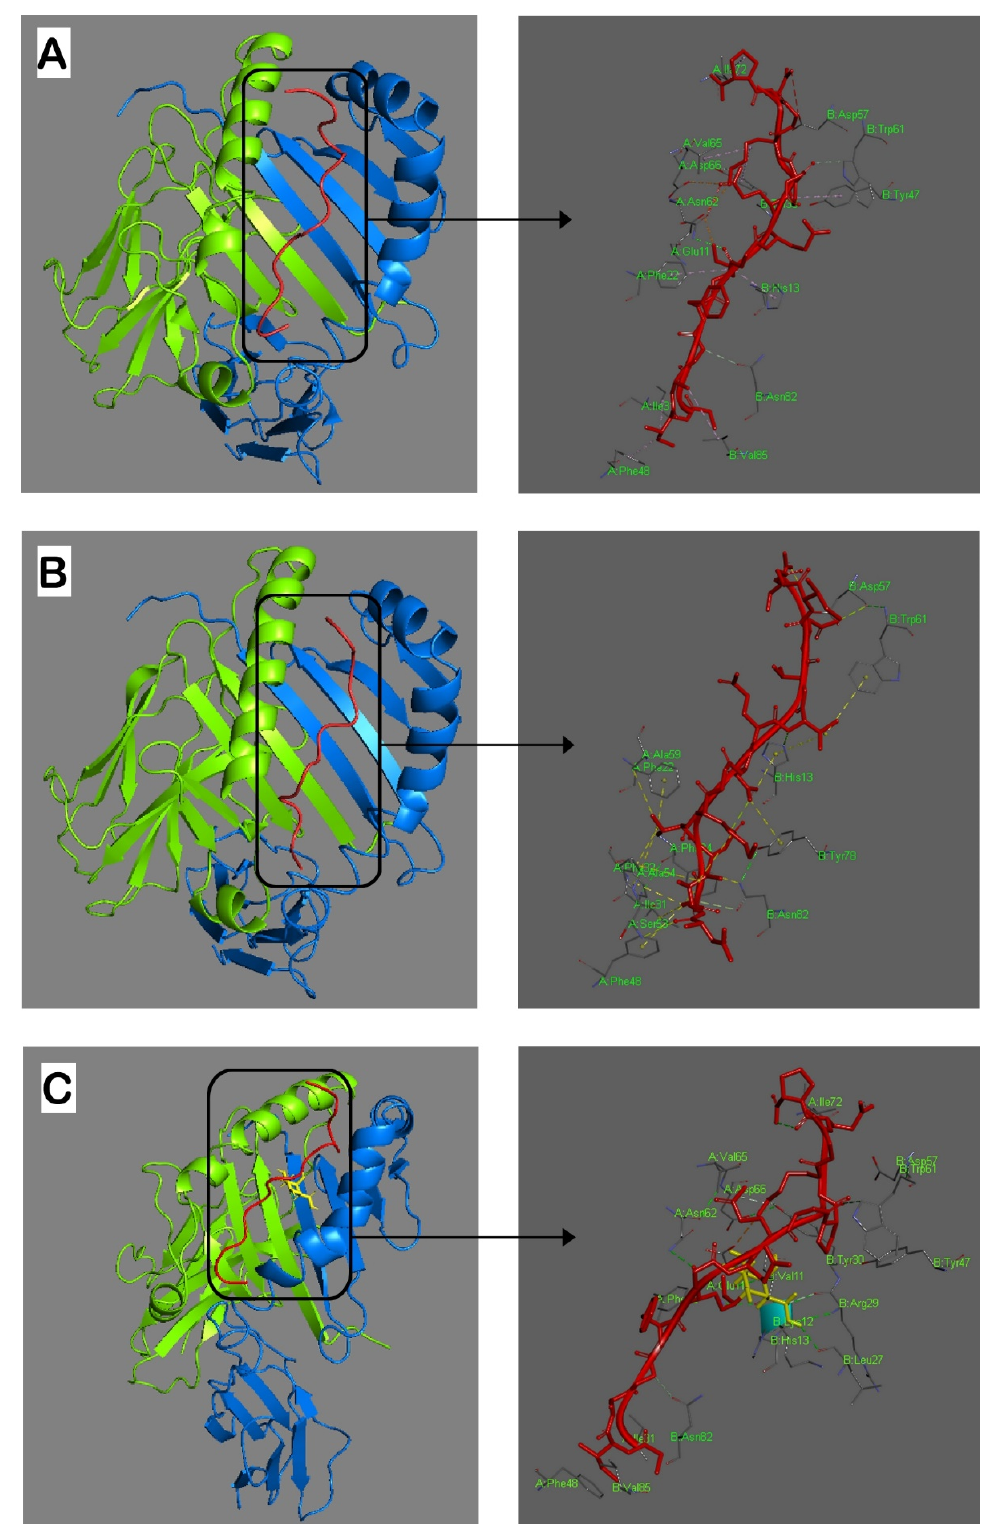
Figure 1. Graphical representation of interaction analyses between the HLA-DRB1*04:01 molecule and the studied peptides (red). ( A ): CII259-273; ( B ): ASNase67-81; ( C ): Gal264-CII259-273. Hydrogen bonds are indicated by dashed lines. Amino acid residues from both α and β chains important for interactions with the peptides are shown in bright green. Gal264 in CII259-273 peptide is yellow. Alpha and beta chains of the MHCII are bright green and blue, respectively. The docking was conducted by using ClusPro 2.2 and the results were visualized using Discovery Studio 2016 V16.1.0.